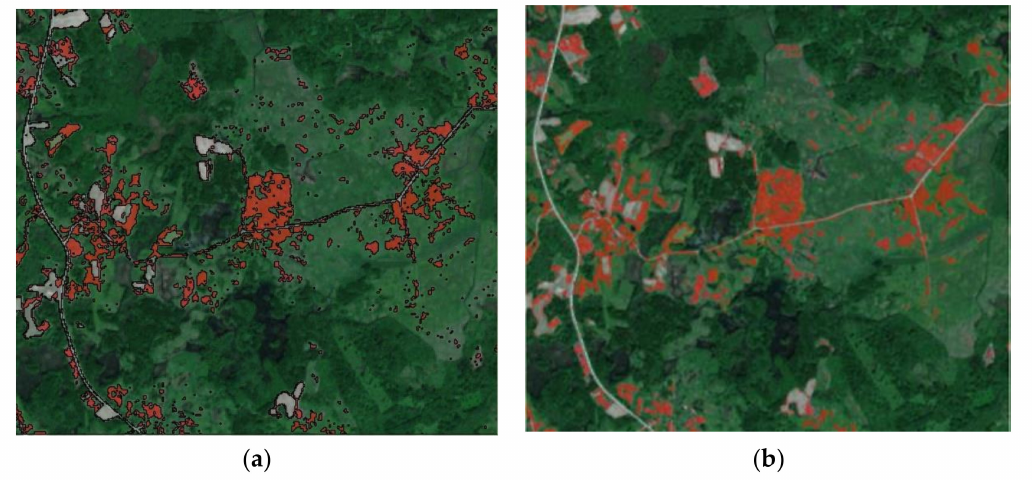
Figure 5. Raster images of H. sosnowskyi plants: ( a ) merging of results; ( b ) image used for correlation processes ( H. sosnowskyi —red, other plants—green, agricultural land—grey).